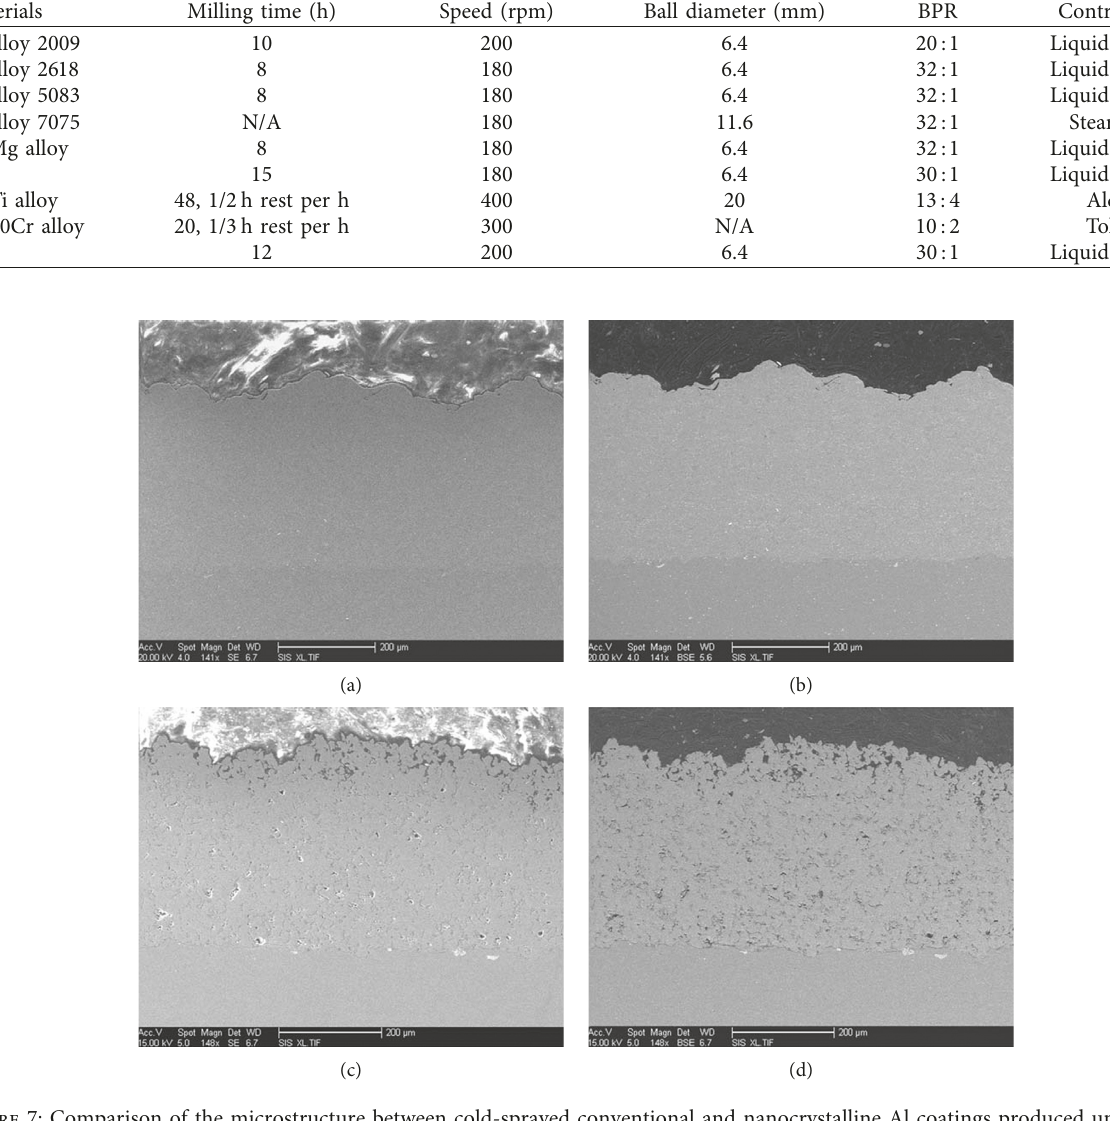
Figure 7: Comparison of the microstructure between cold-sprayed conventional and nanocrystalline Al coatings produced under same working parameters: (a) secondary electron imaging of conventional coating, (b) backscattered electron imaging of conventional coating, (c) secondary electron imaging of nanocrystalline coating, and (d) backscattered electron imaging of nanocrystalline coating